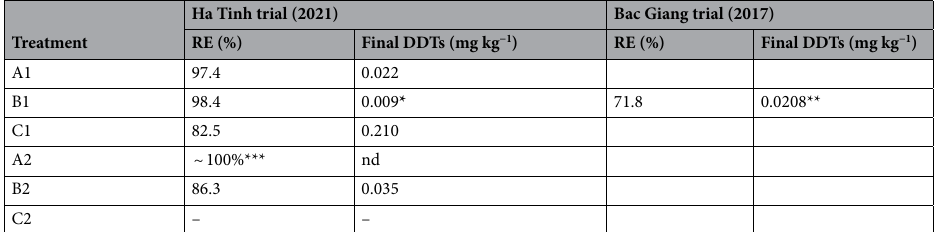
Table 4. Removal efficiencies after 120 days of the field trial. *The concentration is below the permissible threshold of 0.01 mg kg −1 set by the national technical regulation QCVN 15:2008/BTNMT. **Results obtained in the previous trial 12 . ***Assumed value, since the final content of DDTs is undetectable or below the detection limit of the method in samples taken from this